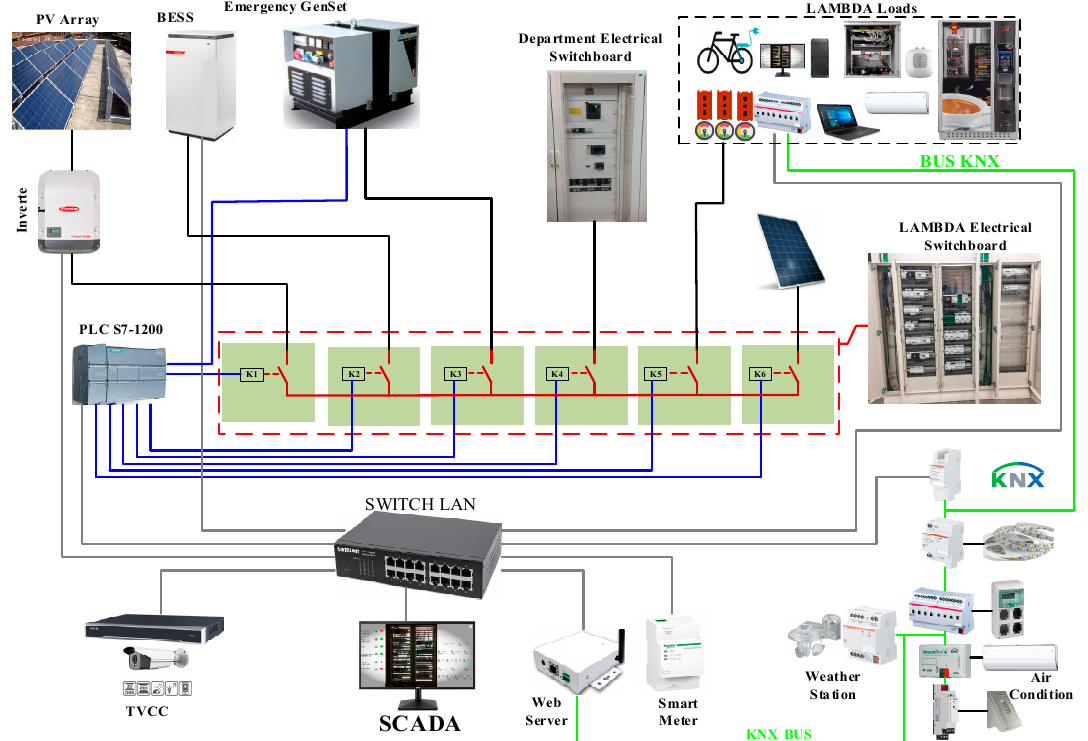
ff erent parts of the LAMBDA MG.